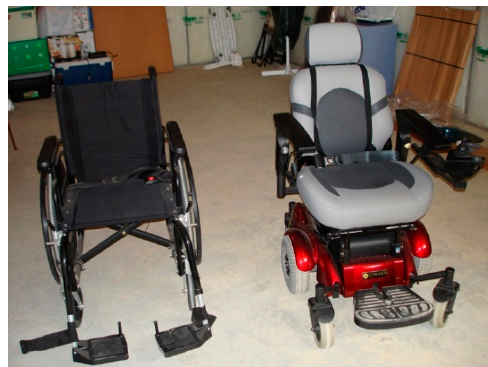
Figure 7. Symbol of disability to an enabler of ability.